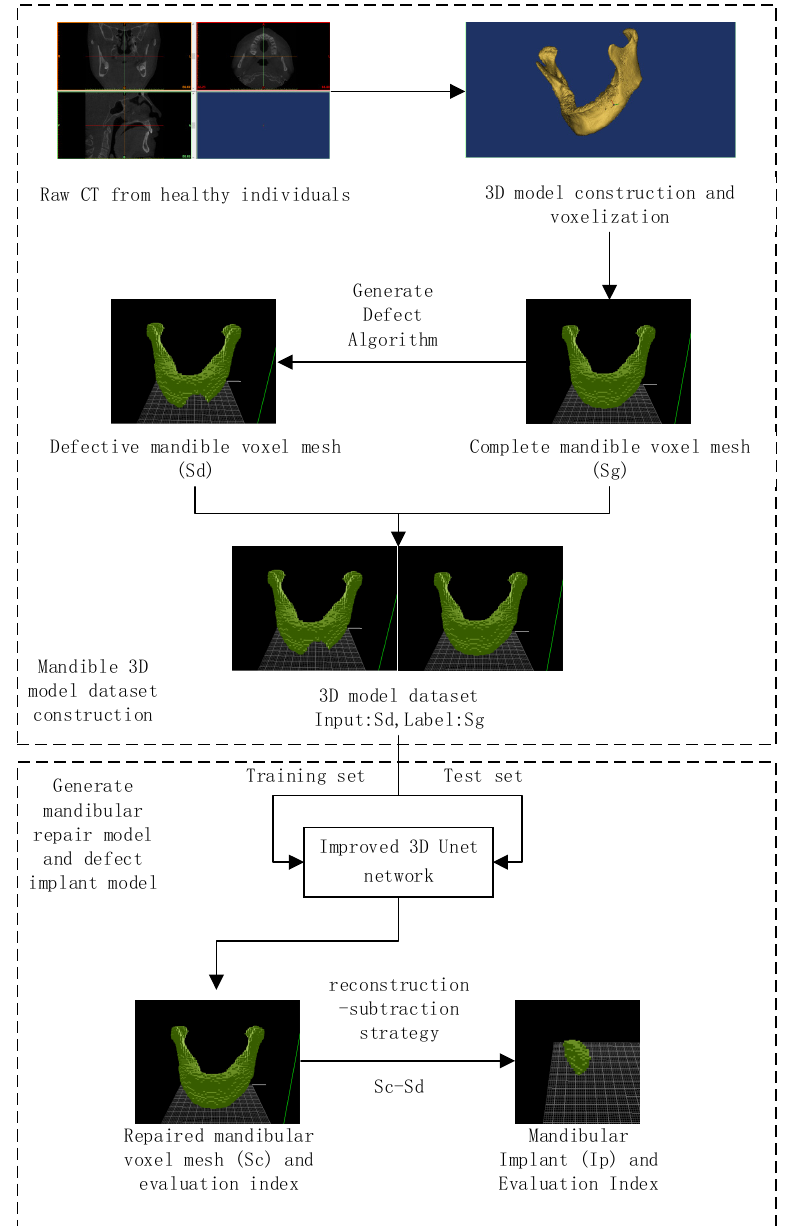
Figure 1. Automatic generation method of mandibular defect repair model based on improved 3D Unet.